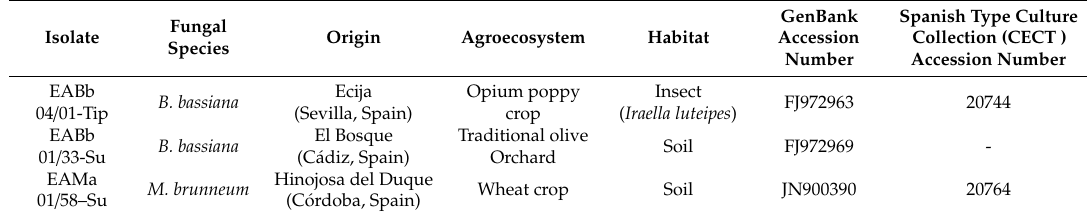
Table 1. Origin of the fungal isolates used in the